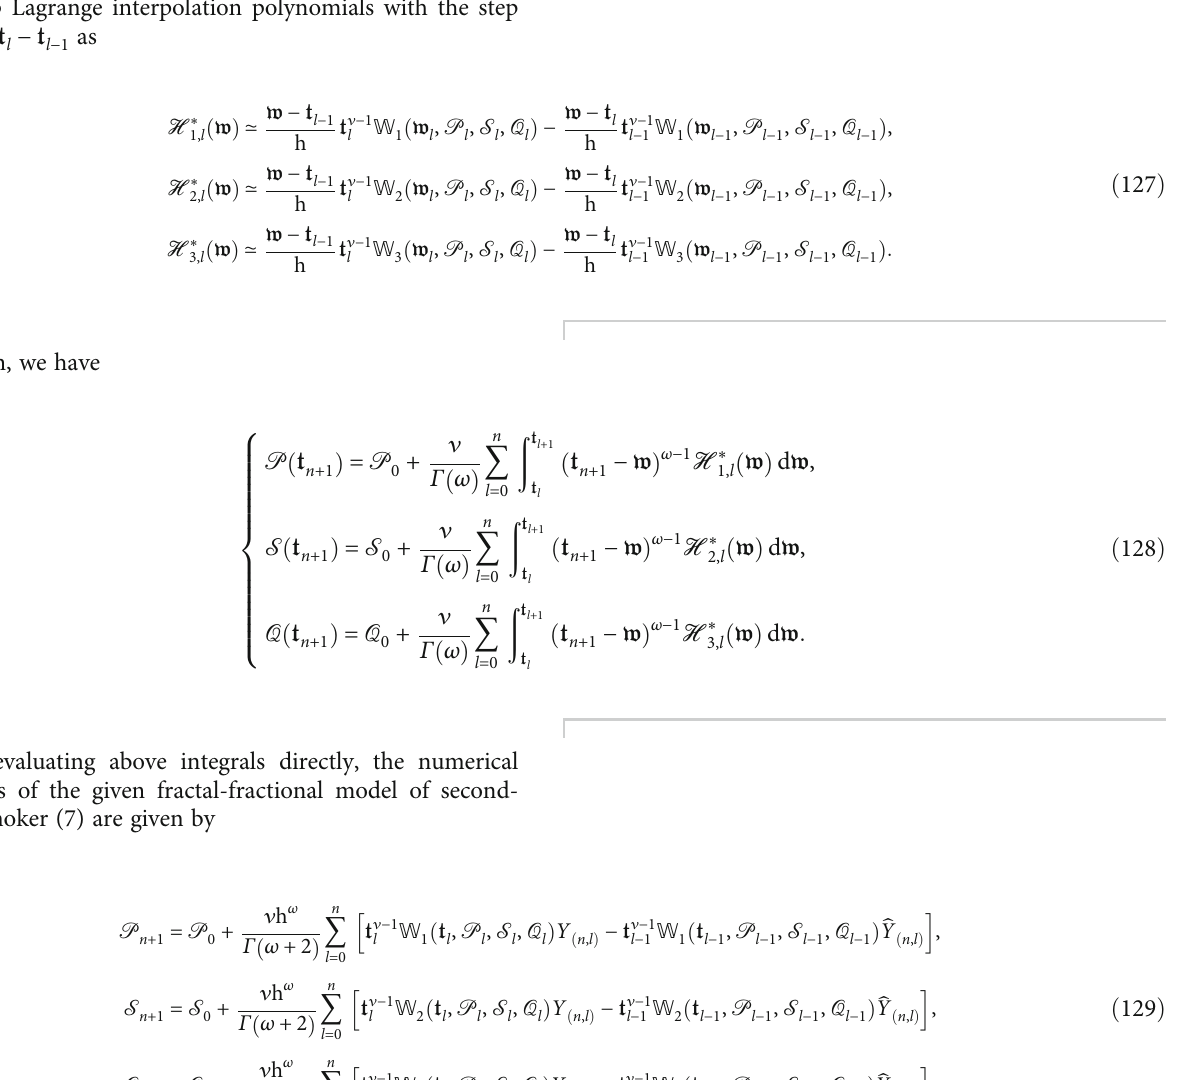
0 (96) and sensitivity analysis